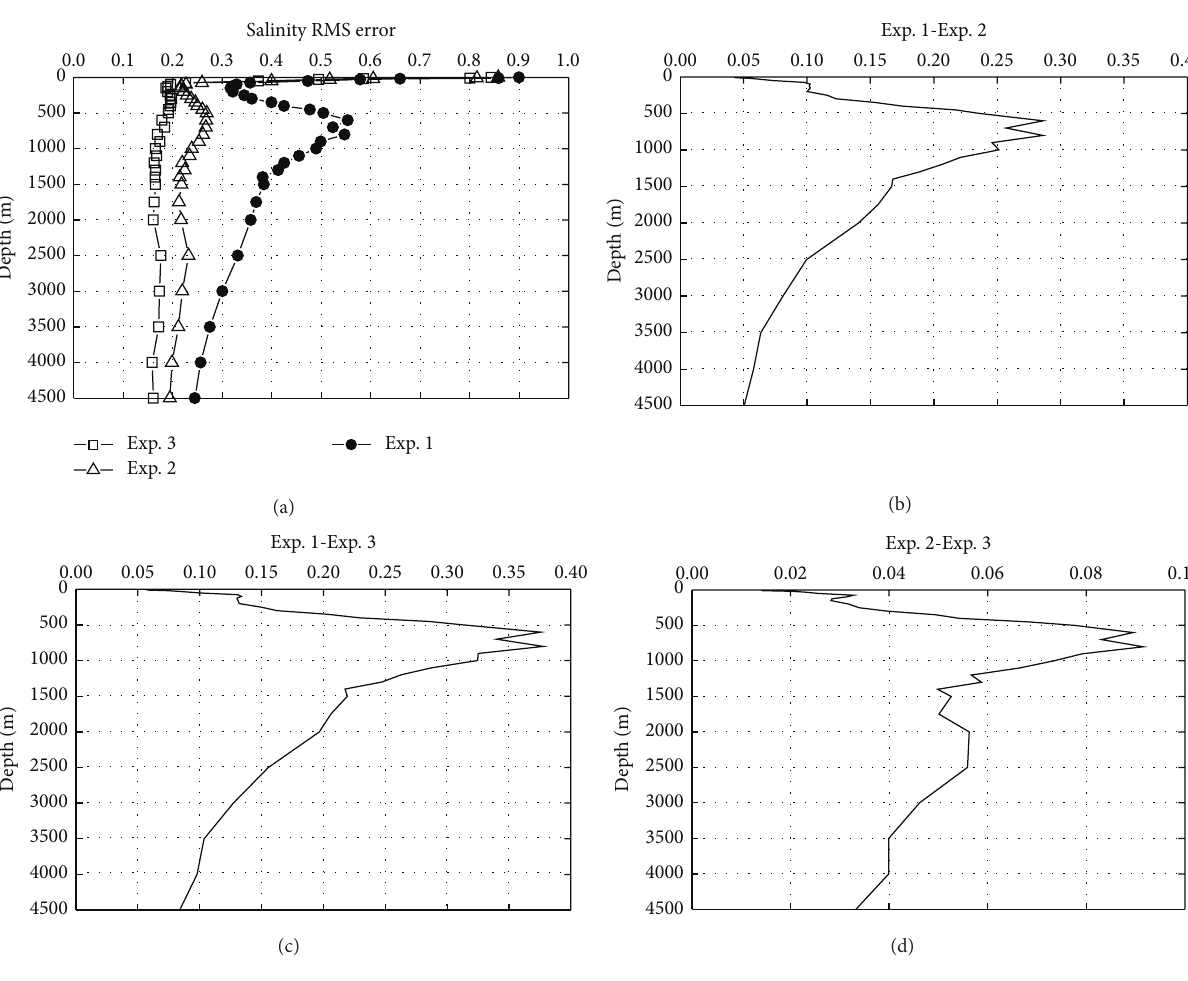
Figure 5: Similar to Figure 4 but for salinity. Unit: